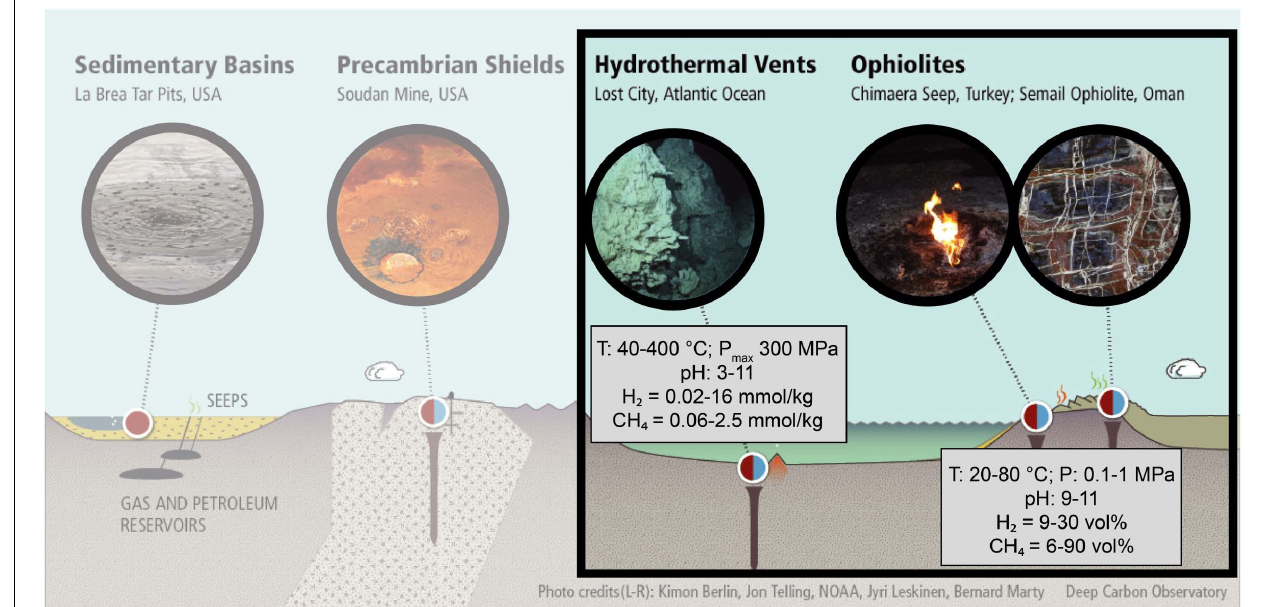
FIGURE 1 | Geologic settings of intense H 2 and CH 4 degassing on Earth. The red and blue colors reflect the biotic and abiotic contributions, respectively, of which the relative fluxes are still under debate. The biotic production includes present-day microbial activity and thermogenic breakdown of organic matter from biological origin. The abiotic production results from radiolysis in Precambrian shields and serpentinization reactions at mid-ocean ridges or in ophiolites. Serpentinization settings are highlighted. (Credit: Josh Wood, modified with permission).